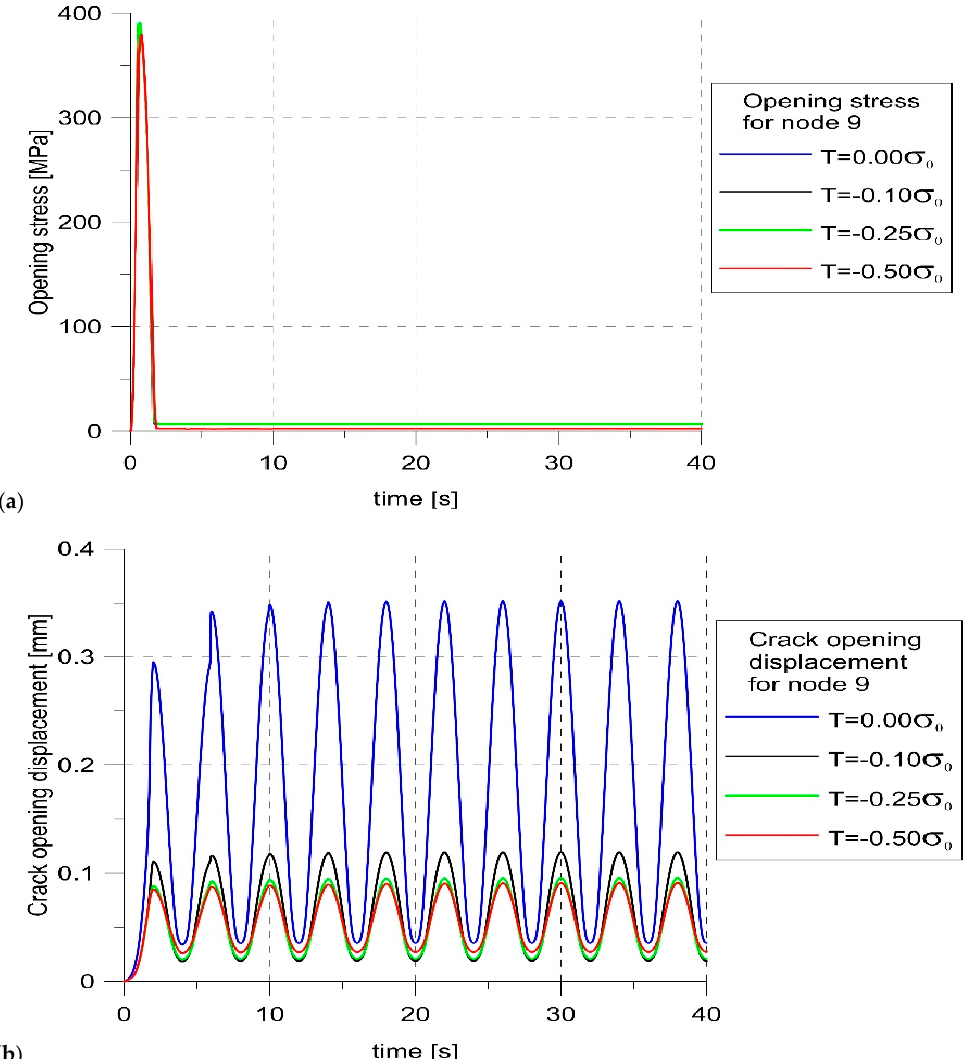
Figure 8. Changes in the opening stress ( a ) and crack opening displacement (COD ( b ) with load for node 9.